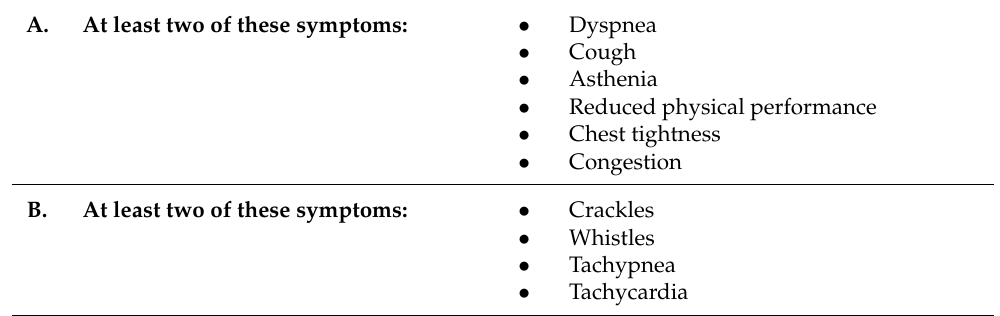
Table 3. Diagnostic criteria for